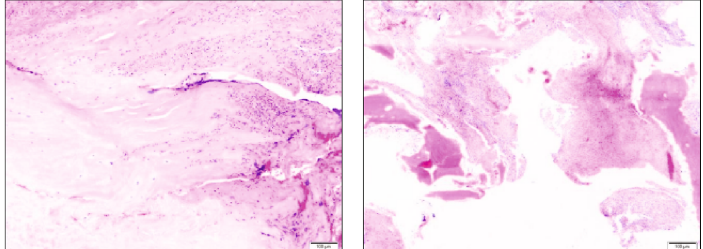
Figure 3: Histologic fi ndings. (a) A capsule biopsy, with massive acute in fl ammation compatible with an infection. (b) A distal clavicle bone sample, with signs of chronic in fl ammation associated with mild acute in fl ammation. There was no